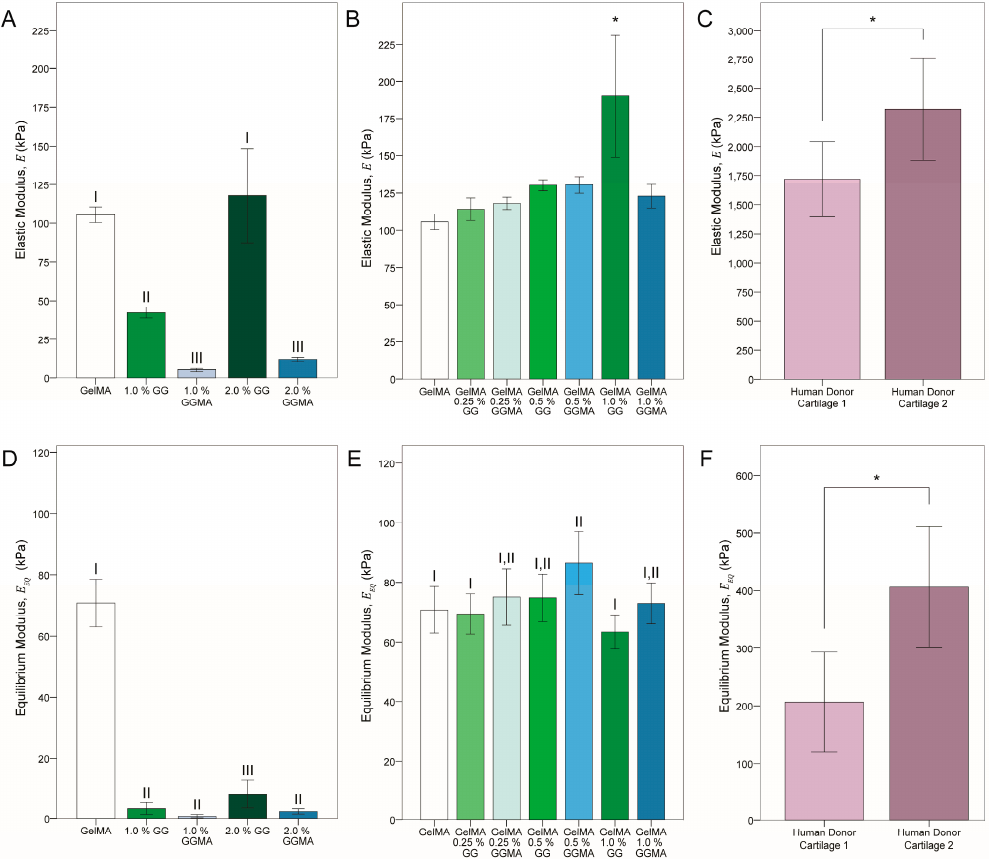
Figure 4. Elastic and equilibrium moduli of all mechanically tested groups. ( A ) Single gel components; ( B ) blended gels; and ( C ) human donor explants. Equilibrium moduli are also shown for ( D ) single gel components; ( E ) blended gels; and ( F ) explants. Asterisks (*) indicate significant difference compared to all other groups; shared Roman numerals indicate statistical similarity; n = 5 in all cases.